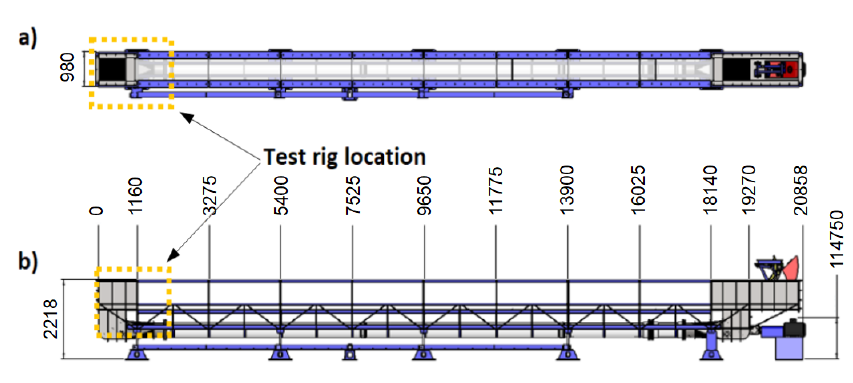
Figure 1. Sketch of the 20 m two dimensional flume of the Coast Laboratory (University of Plymouth). The yellow dashed lines mark the area where the test rig was placed. ( a ) Plan view. ( b ) Cross-section.